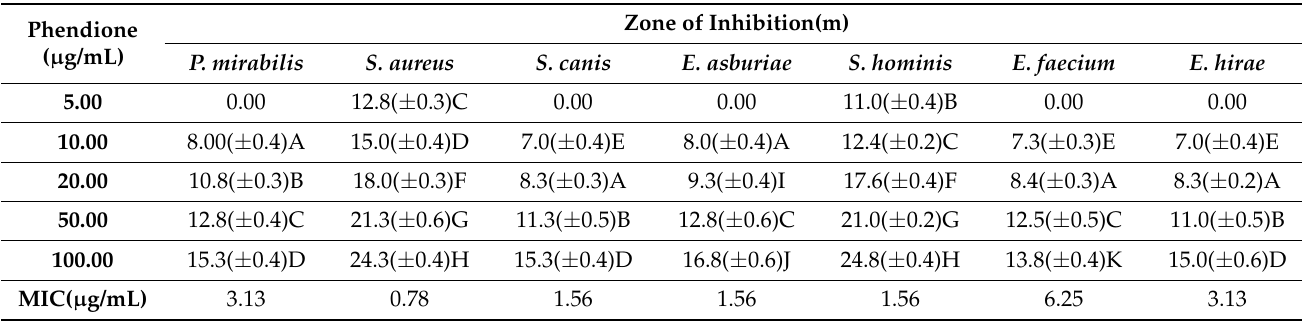
Table 2. Zones of inhibition (mm) produced by phendione for bacterial co-isolates in canine dermal cases of infection and minimum inhibitory